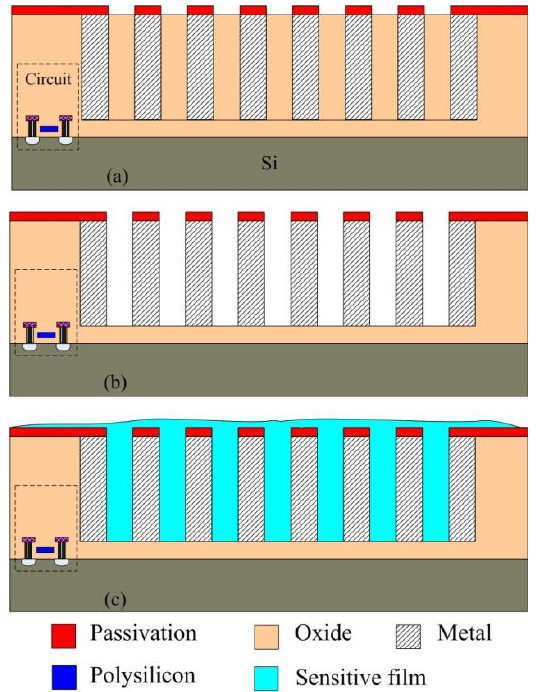
Figure 6. Fabrication process of the integrated humidity sensor: ( a ) after the CMOS process; ( b ) etching the sacrificial layer; ( c ) coating the sensitive